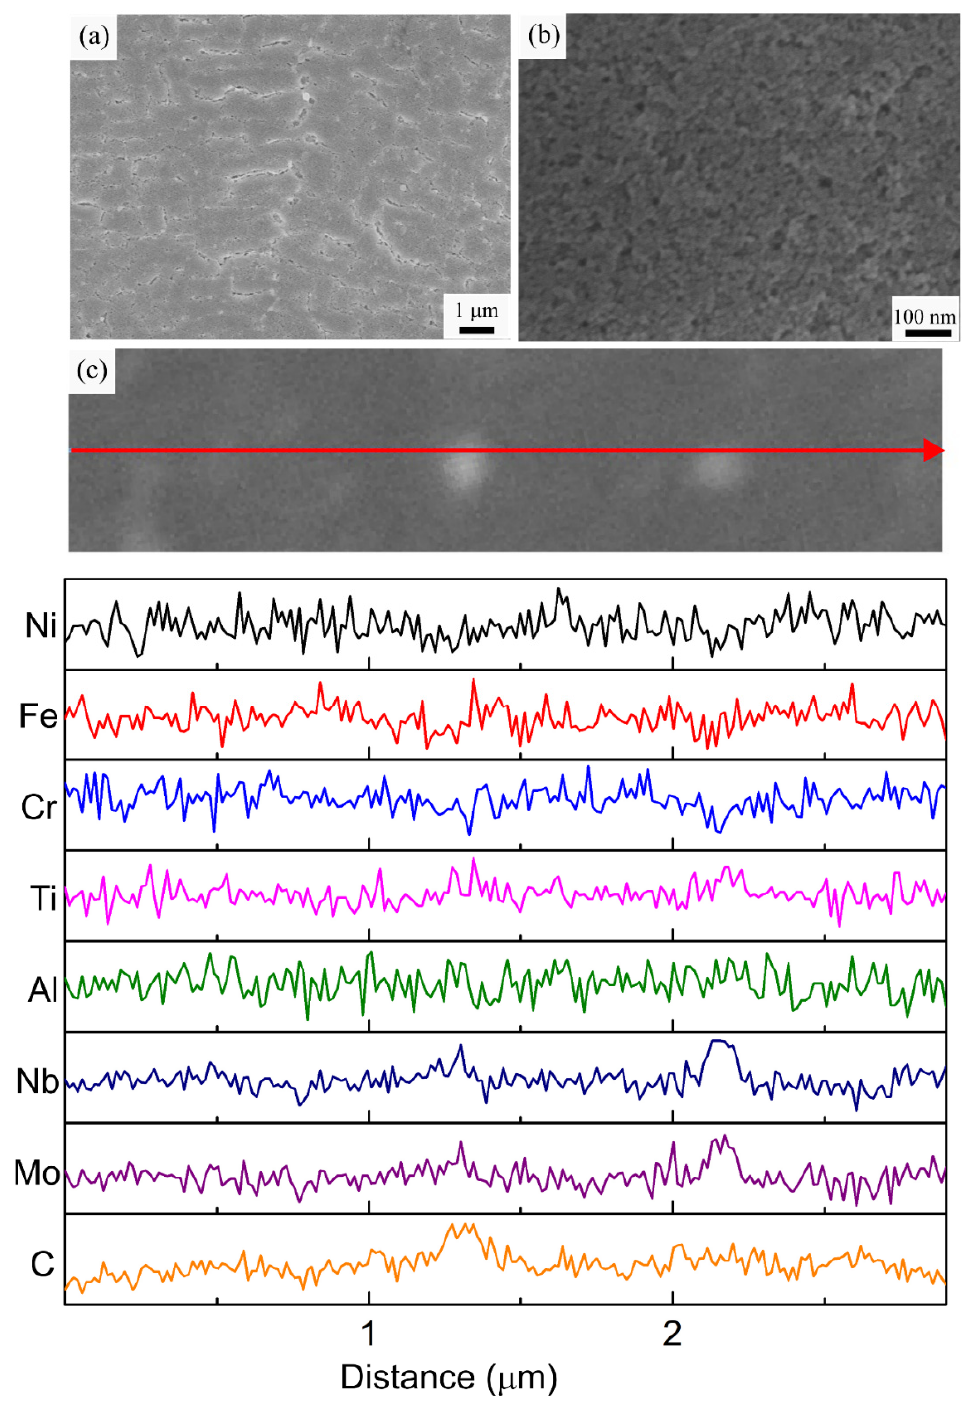
Figure 11. ( a , b ) Representative SEM micrographs, ( c ) EDS line scan analysis of the HT4 specimen along the marked red arrow.